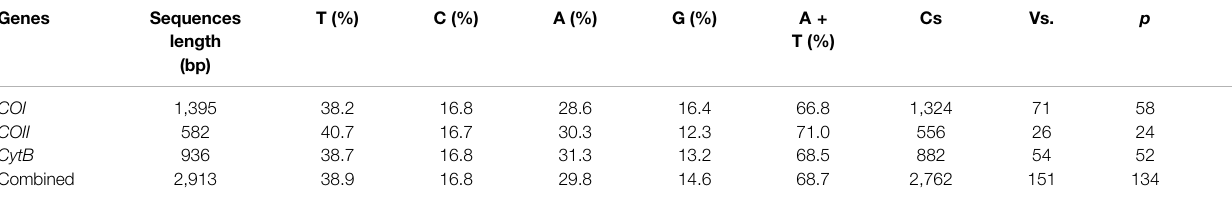
TABLE 2 | Variation of COI , COII , CytB and combined genes of 17 populations of A. mali . Genes Sequences length